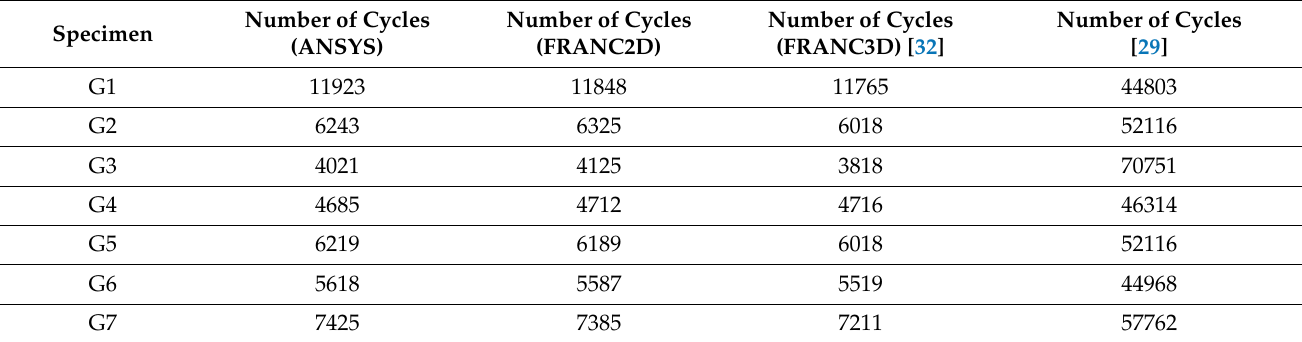
Table 3. Comparison for the fatigue life cycles for all specimens.